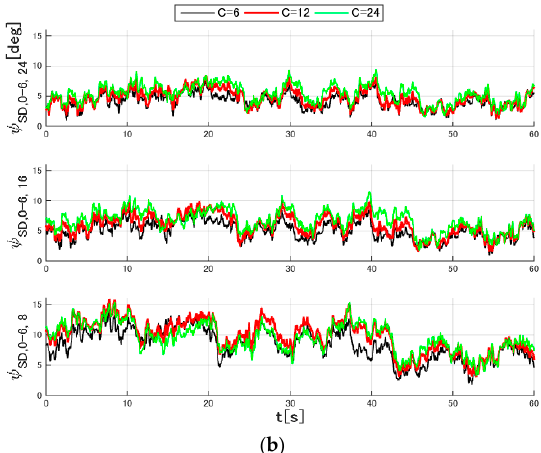
Figure 6. Example of the time history of the standard deviation of seven wind turbines (16 m/s at the centre rotor, 0–60 s): ( a ) wind speed and ( b ) yaw angle.